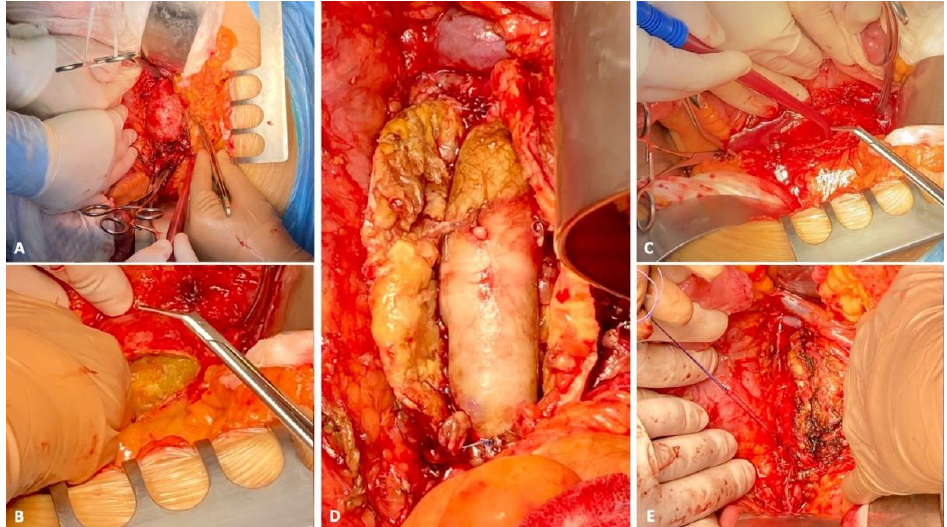
Figure 4. Infrarenal aortic aneurysm repair with cryopreserved aortic allograft surgical steps: (Panel